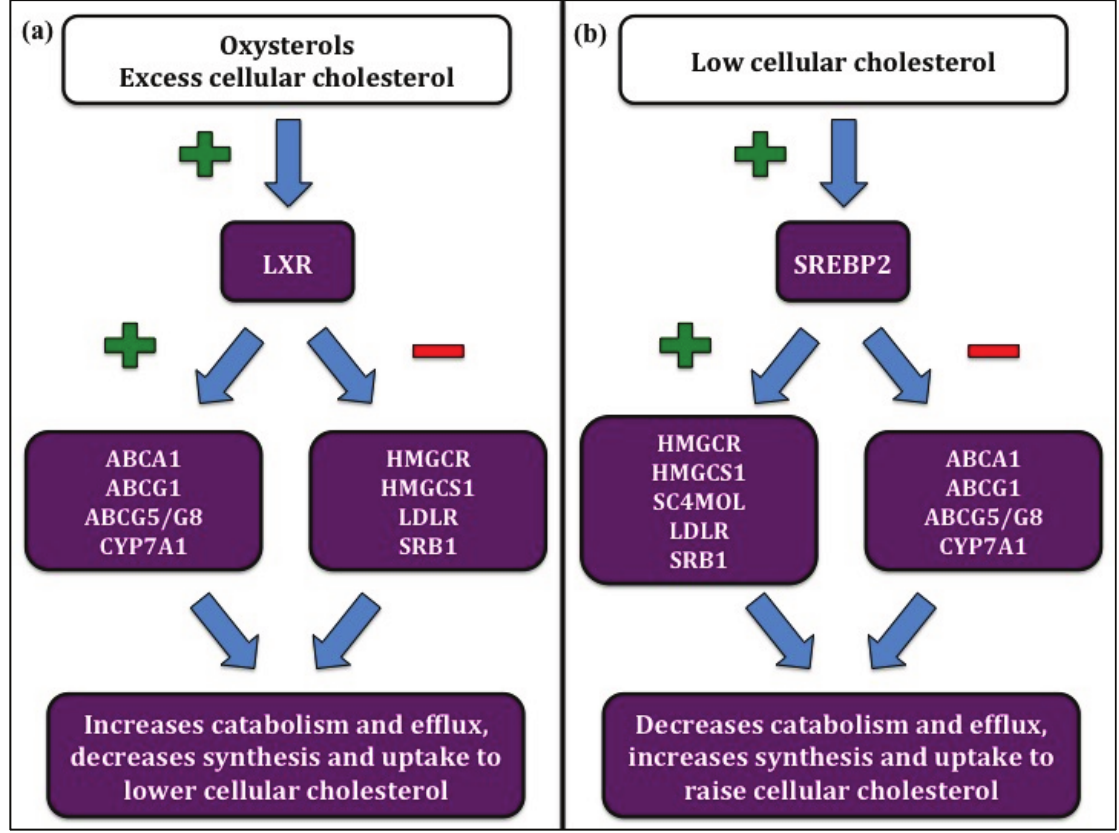
Figure 1. Regulation of cellular cholesterol homeostasis. ( a ) Liver X receptor (LXR) is activated by excess cellular cholesterol. LXR activation increases cholesterol efflux and catabolism by upregulating ATP binding cassette A1 (ABCA1), ATP binding cassette G1 (ABCG1), ATP binding cassette G5/G8 (ABCG5/G8), and cholesterol 7(cid:2) hydroxylase (CYP7A1), and decreases cholesterol synthesis and uptake by suppressing 3-hydroxy-3-methylglutaryl CoA reductase (HMGCoA-R), 3-hydroxy-3-methylglutaryl CoA synthase 1 (HMGCoA-S1), LDL receptor (LDLR), and scavenger receptor B1 (SRB1). ( b ) Sterol regulatory element-binding protein 2 (SREBP2) is upregulated by low cellular cholesterol. SREBP2 upregulates cholesterol synthesis and uptake by increasing HMGCoA-R, HMGCoA-S1, methylsterol monoxygenase (SC4MOL), LDLR, and SRB1, and decreases cholesterol efflux and catabolism by suppressing ABCA1, ABCG1, ABCG5/G8, and